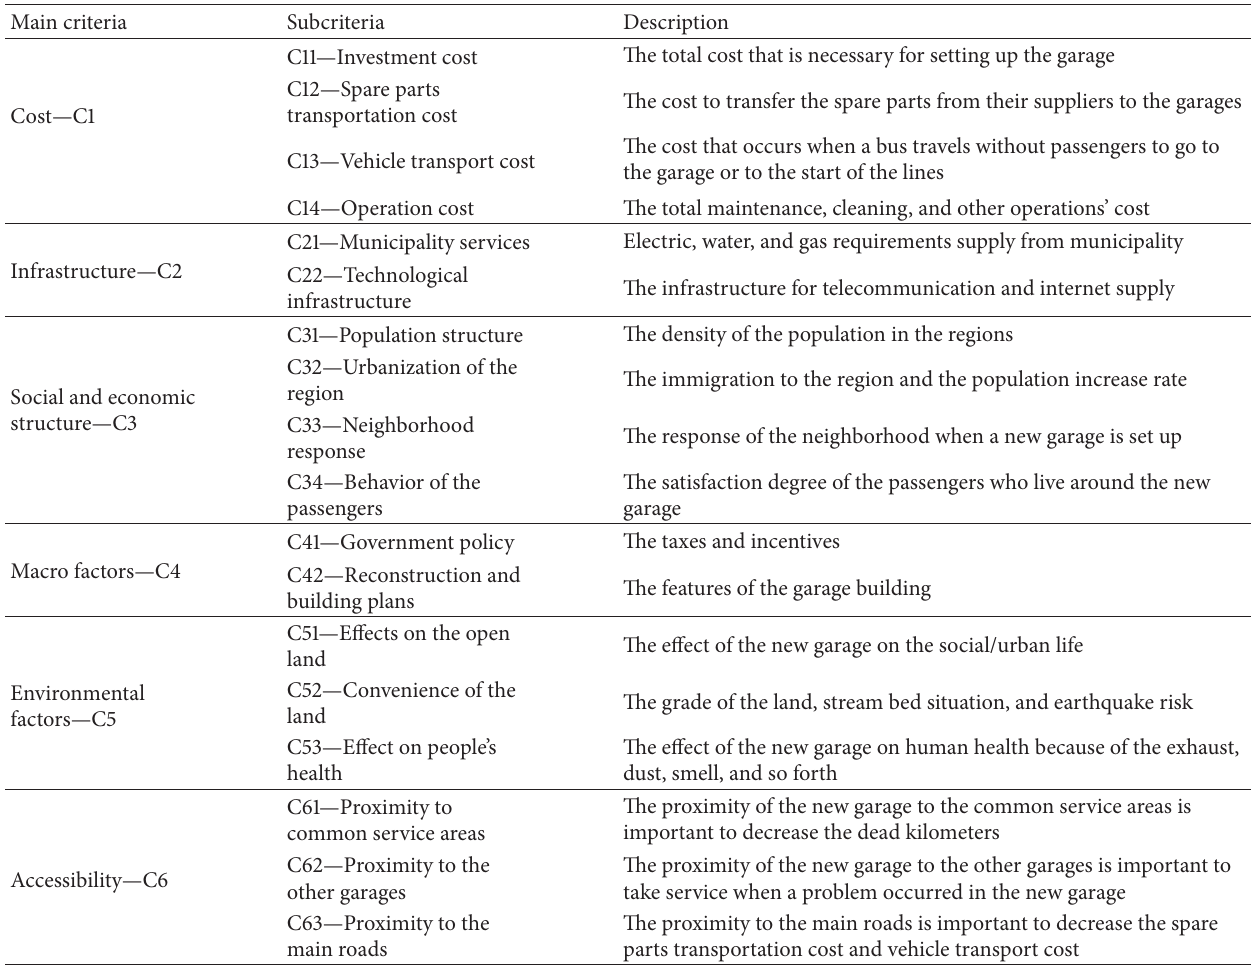
Table 3: The description of the criteria.